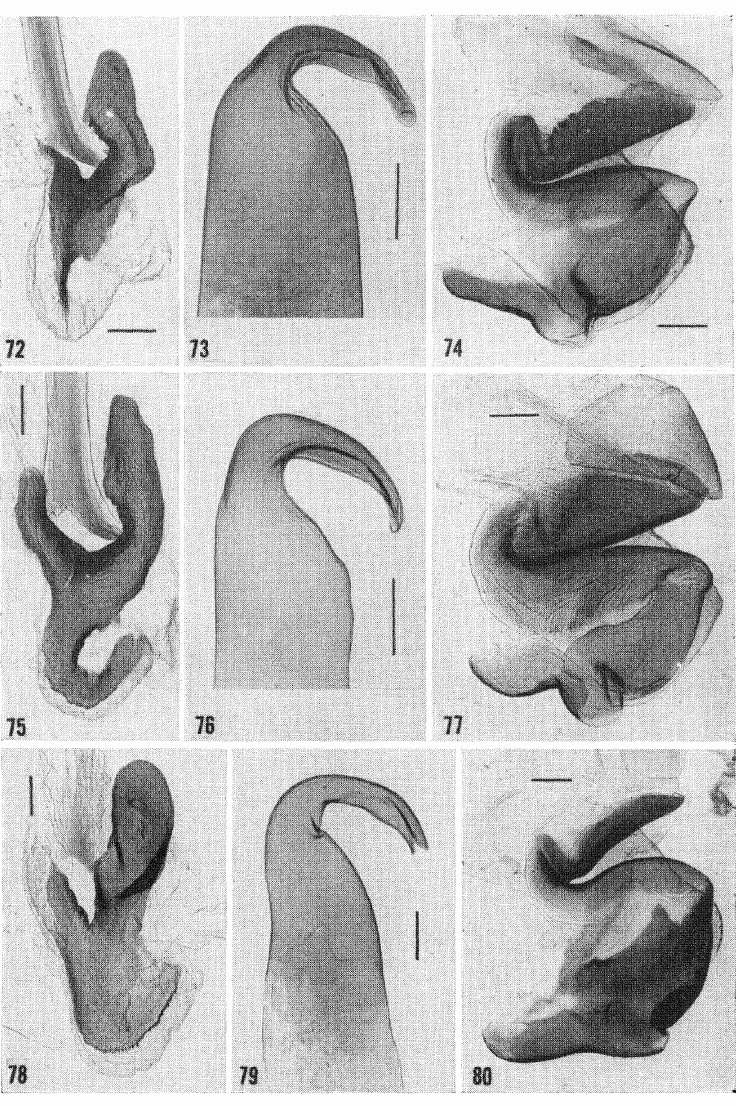
Figs. 72-80. 72-77. Phortioeca nimbata. 72-74. (101 ANSP). (from adult shown in Fig. 14). 75-77. (107 ANSP). La Forestire, Haut Maroni, French Guiana. 78-80. (5 BMNH). Phortioeca maxSmiliani. (from adult shown in Fig. 17). (scale 0.2